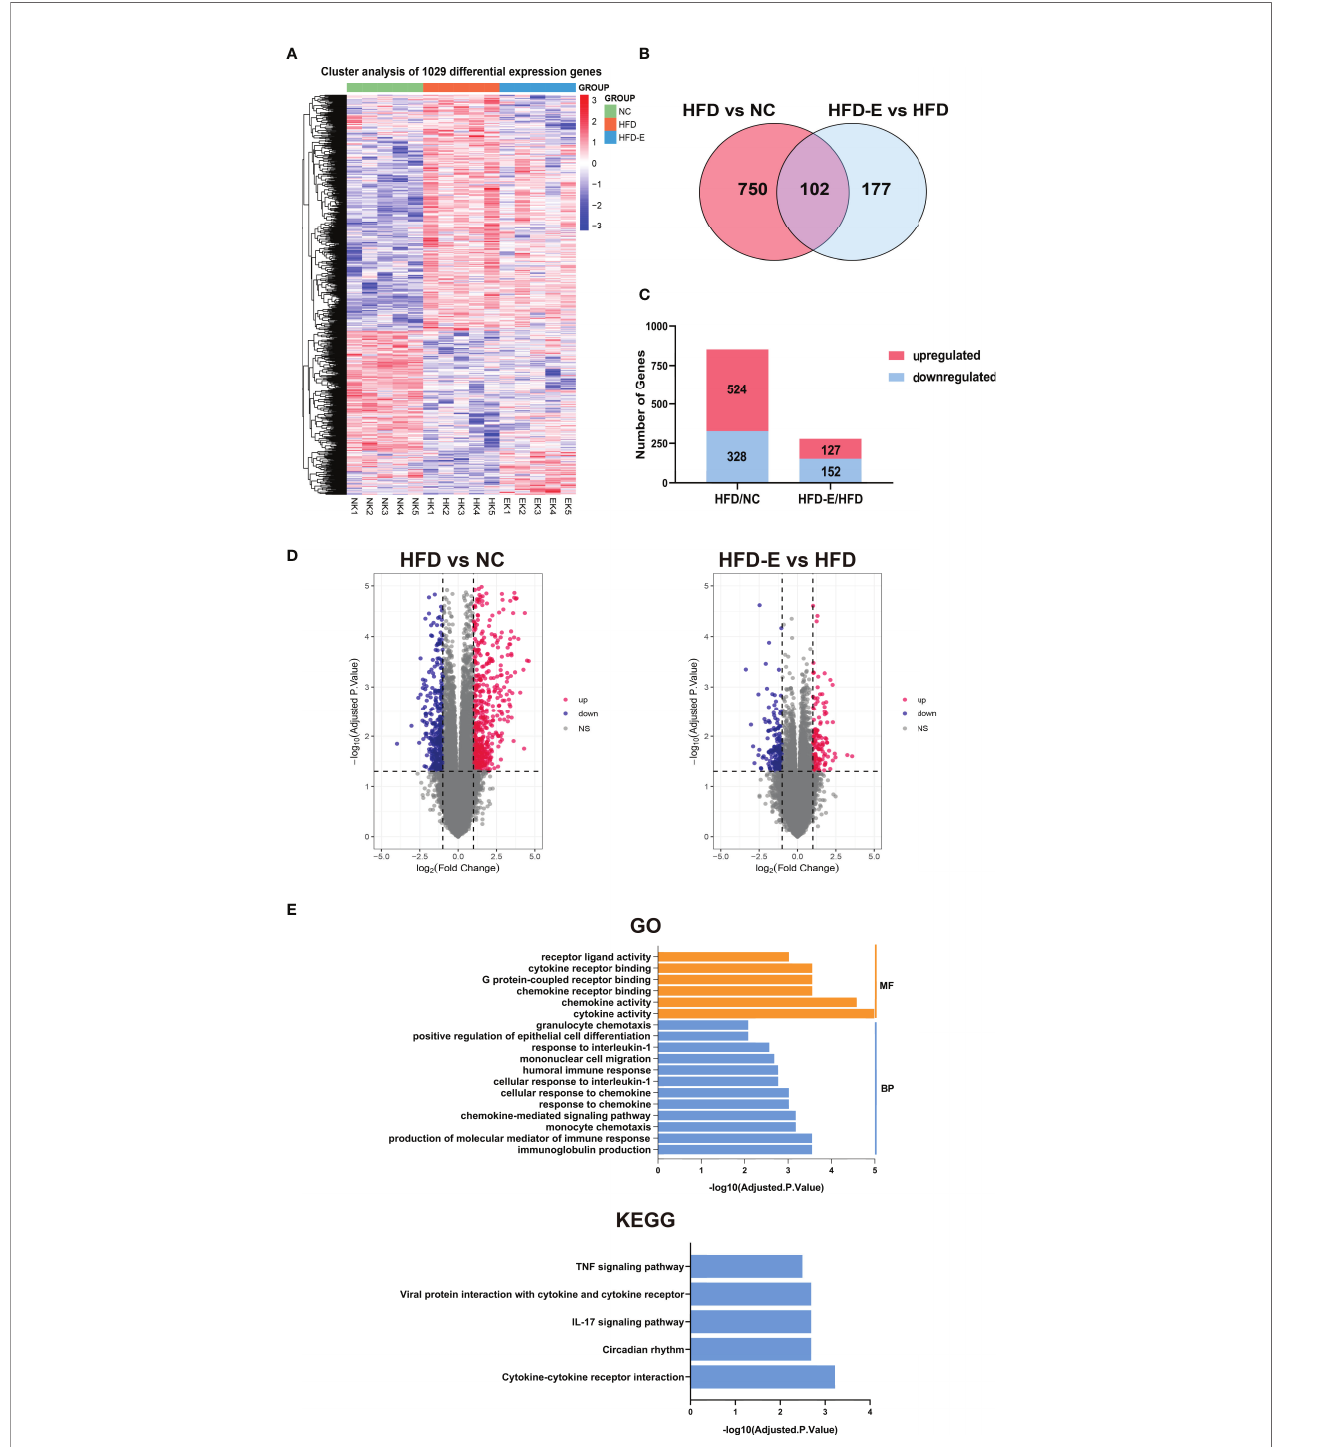
FIGURE 3 | Kidney tissue were collected and then subjected to RNA-seq analysis. (A) The DEGs of HFD vs. NC and HFD-E vs. HFD. (B) . DEGs associated with HFD vs. NC and HFD-E vs. HFD (light red and blue). (C) The number of upregulated and downregulated genes from the HFD vs. NC, and HFD-E vs. HFD in the mice renal genome. (D) Volcano plot for the distribution of DEGs between the HFD vs. NC and HFD-E vs. HFD. Blue represents a down-regulation in expression, red represents upregulation and gray represents no signi fi cance compared to control. (E) Main GO terms and KEGG pathways based on shared DEGs between HFD vs. NC and HFD-E vs.